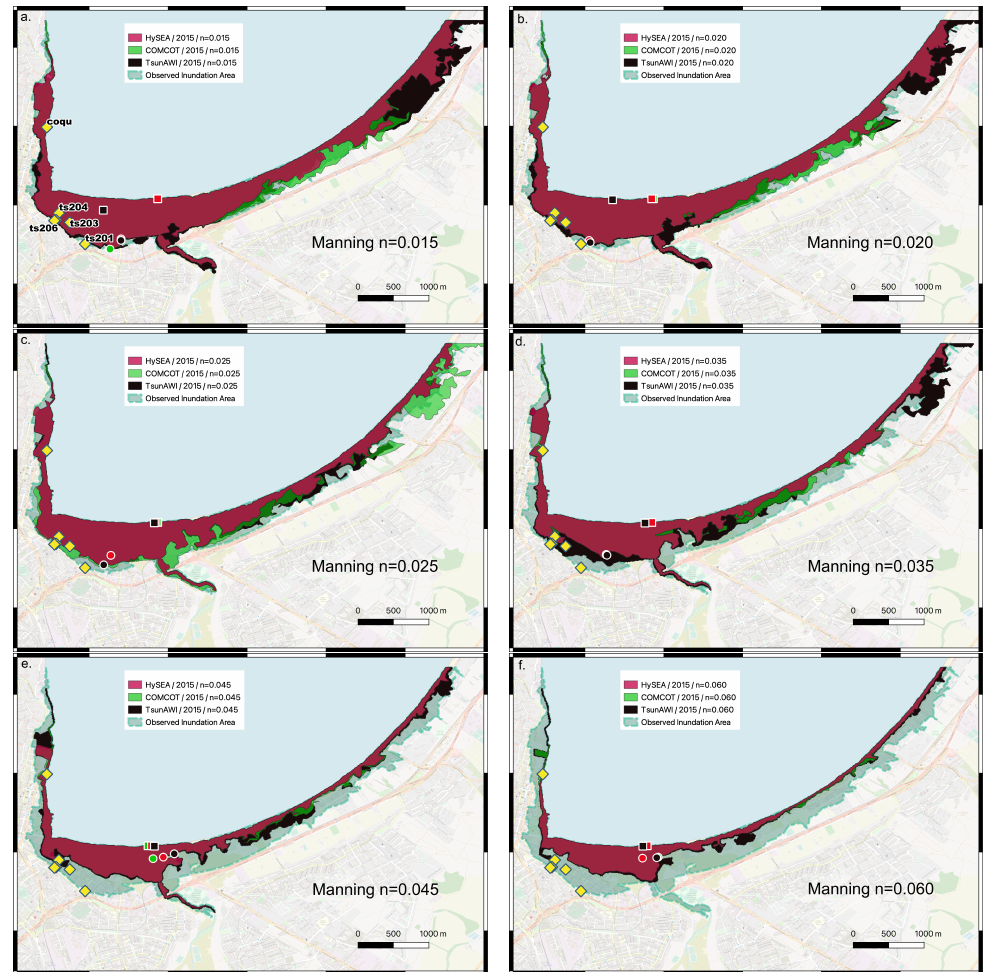
Figure 7. Comparison of the inundation areas in Coquimbo resulting from three numerical codes with different Manning values obtained based on the Experiment 2015. ( a ). Manning n value of 0.015. ( b ). Manning n value of 0.020. ( c ). Manning n value of 0.025. ( d ). Manning n value of 0.030. ( e ). Manning n value of 0.045. ( f ). Manning n value of 0.060. Yellow diamonds are virtual tide (coqu) and inland gauges, squares (red, black, green) show positions of the maximum inundation, while circles (red, black, green) show positions of the maximum run-up. Refer to Table S1 (in Supplementary Materials) where these values are summarized. The observed inundation area was taken from SERNAGEOMIN [43]. Basemap: © OpenStreetMap